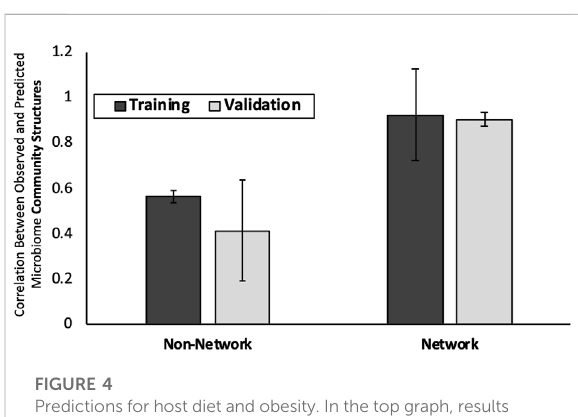
FIGURE 4 Predictions for host diet and obesity. In the top graph, results for prediction of hostdietfrom microbiomedataare shown. Inthe bottom graph, results for prediction of host obesity state from microbiome data are shown. Y-axis is MCC score for binary classi fi cation quality. The nature of the data used, “ Microbial Community Structure ” or “ Microbial Community Metabolome ” , to train the models are listed on the X-axis. Results are presented for both training and validation data